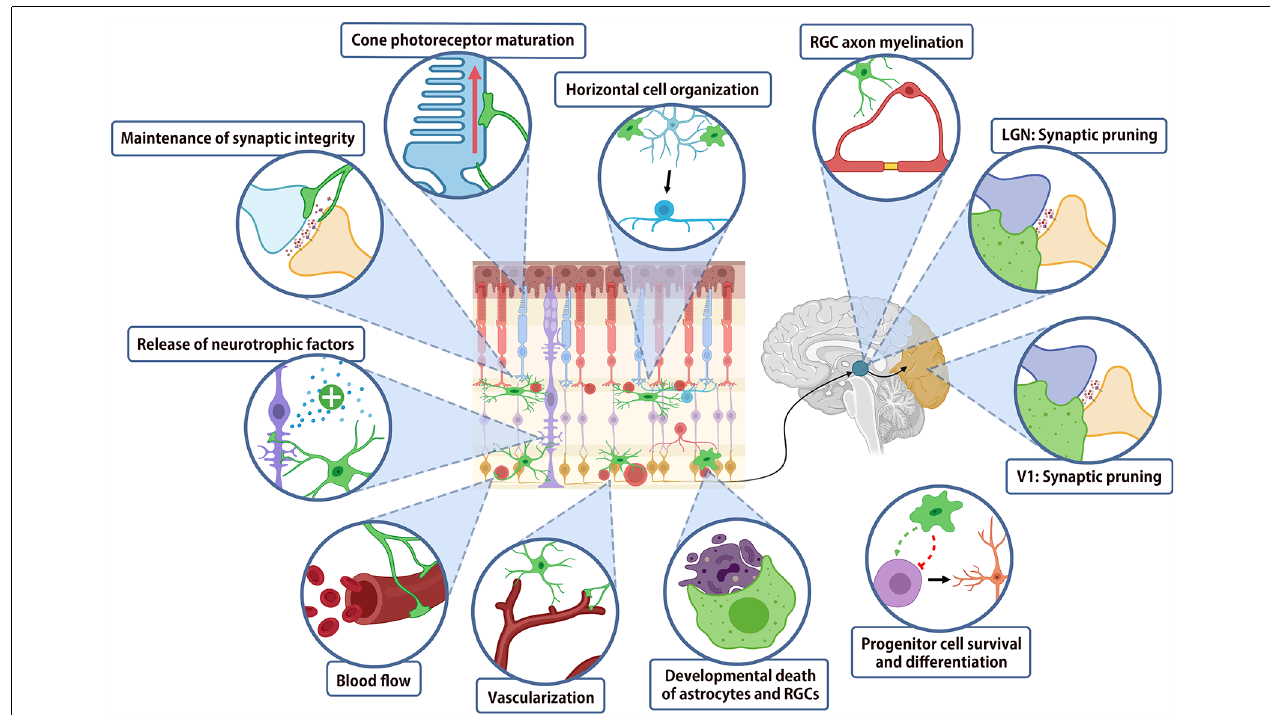
FIGURE 2 | Summary of microglial function in retina and higher order visual centers. Schematic diagram summarizing the major functions of microglia in the development and homeostasis of the visual